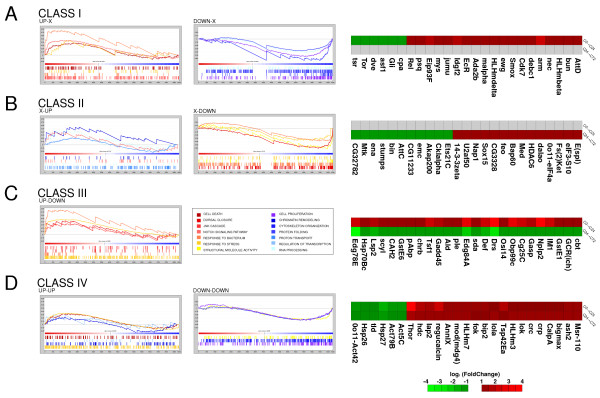
Gene class signature of wing imaginal disc regeneration. Functional signature and expression map for each gene class defined during wing imaginal disc regeneration. (Left panel) Enrichment plots for statistically significant GO categories identified for Class I (A), Class II (B), Class III (C) and Class IV (D) genes. ES values indicate overrepresentation of GO terms in each class. The zero cross mark indicates the point in which the ratio between expression in C0→C24 and C24→C72 is 0. (Right panel) Expression maps of representative genes of each class. Red is used for upregulation, green for downregulation and grey for no significant change in expression levels (see scale bar).